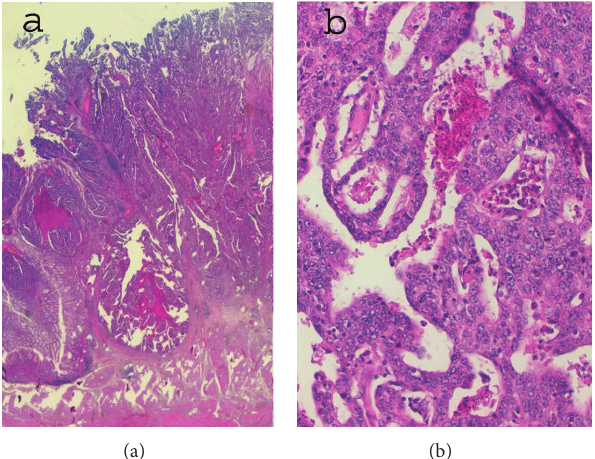
Figure 2: Gastric adenocarcinoma: (a) adenocarcinoma infiltrating depth muscular wall—10x and (b) moderately differentiated tubulo- papillary adenocarcinoma—20x.